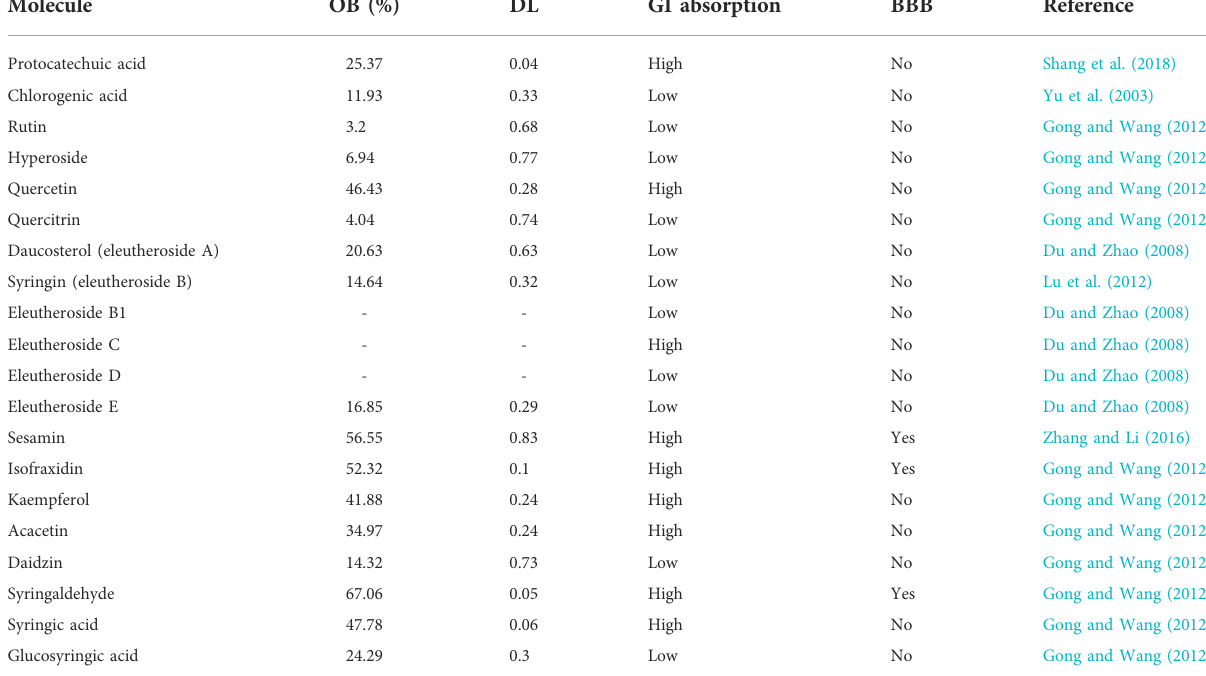
TABLE 1 Information of active compounds in ASH.